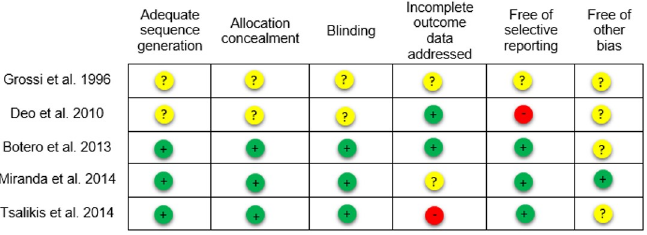
Fig 2. Ascertainment of the risk of bias in the included studies. + = yes; — = no;? =